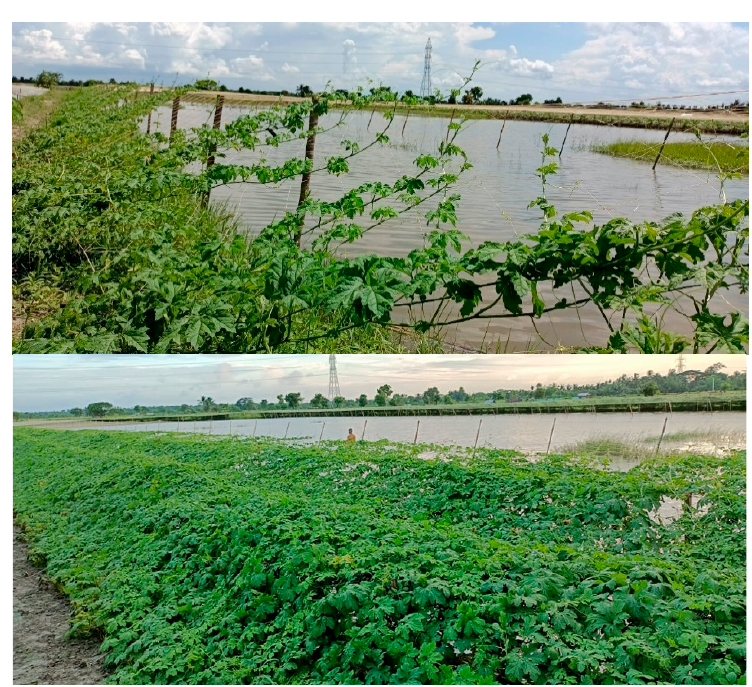
Figure 2. I ntegrated rice–prawn–vegetable farming system in wet season showing the veg- etables on the embankment (Photo by the first author). 3.3. Economic Benefit Analysis